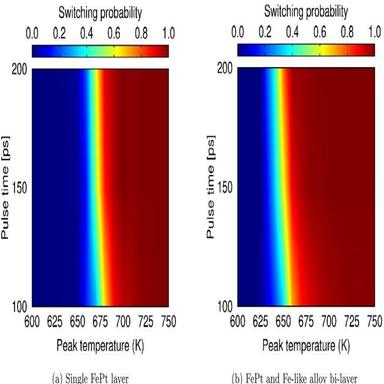
Switching probability as a function of peak temperature and pulse duration for a single FePt recording medium and an ECC recording medium. The ECC system shows an increased switching probability for both shorter pulse duration and lower peak temperatures compared to the single layer FePt.